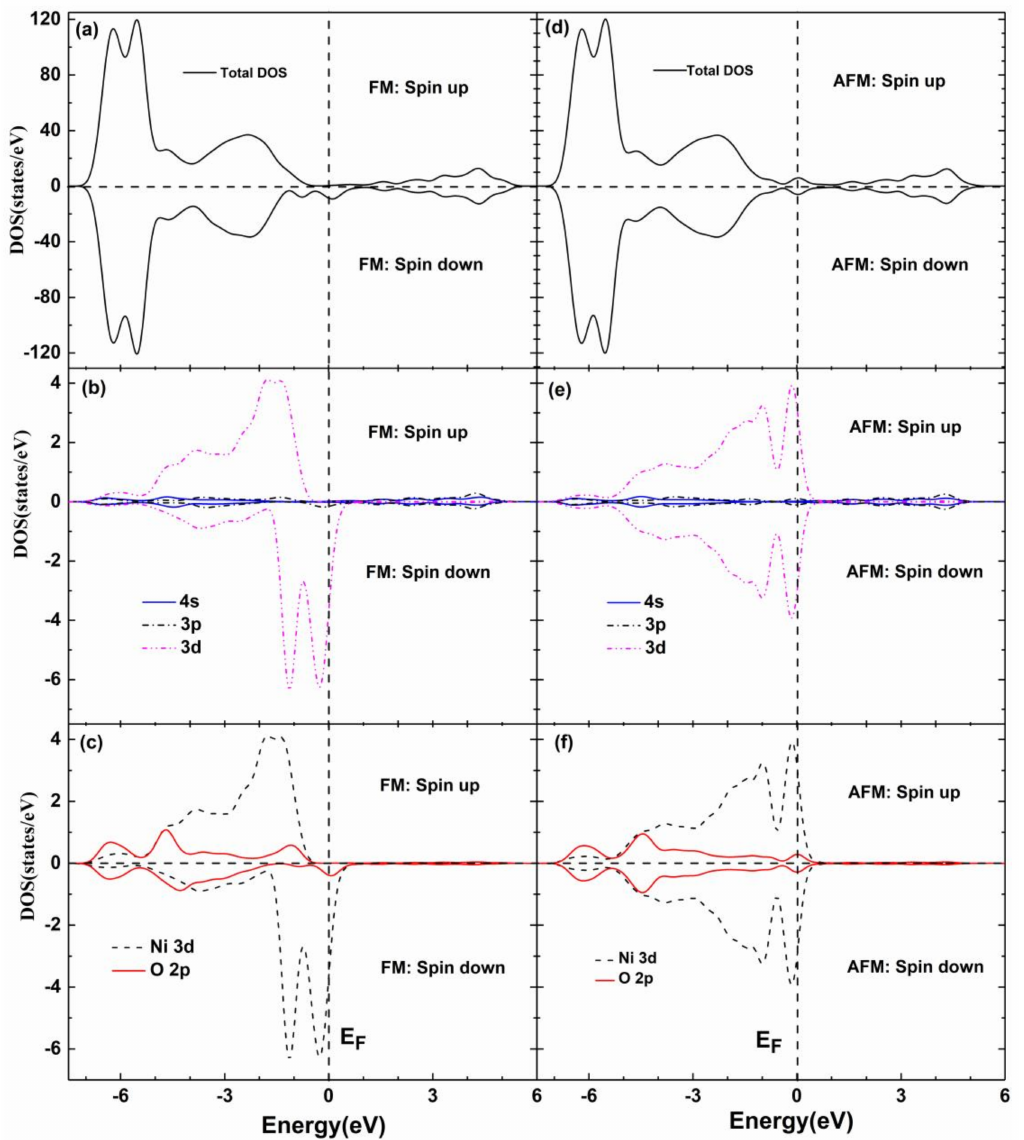
Figure 4. Total and partial DOS of Ni-doped ZB ZnO. ( a ) total DOS of FM; ( b ) partial DOS of Ni atoms for FM; ( c ) partial DOS of Ni 3 d and O 2 p for FM; ( d ) total DOS of AFM; ( e ) partial DOS of Ni atoms for AFM; ( f ) partial DOS of Ni 3 d and O 2 p for